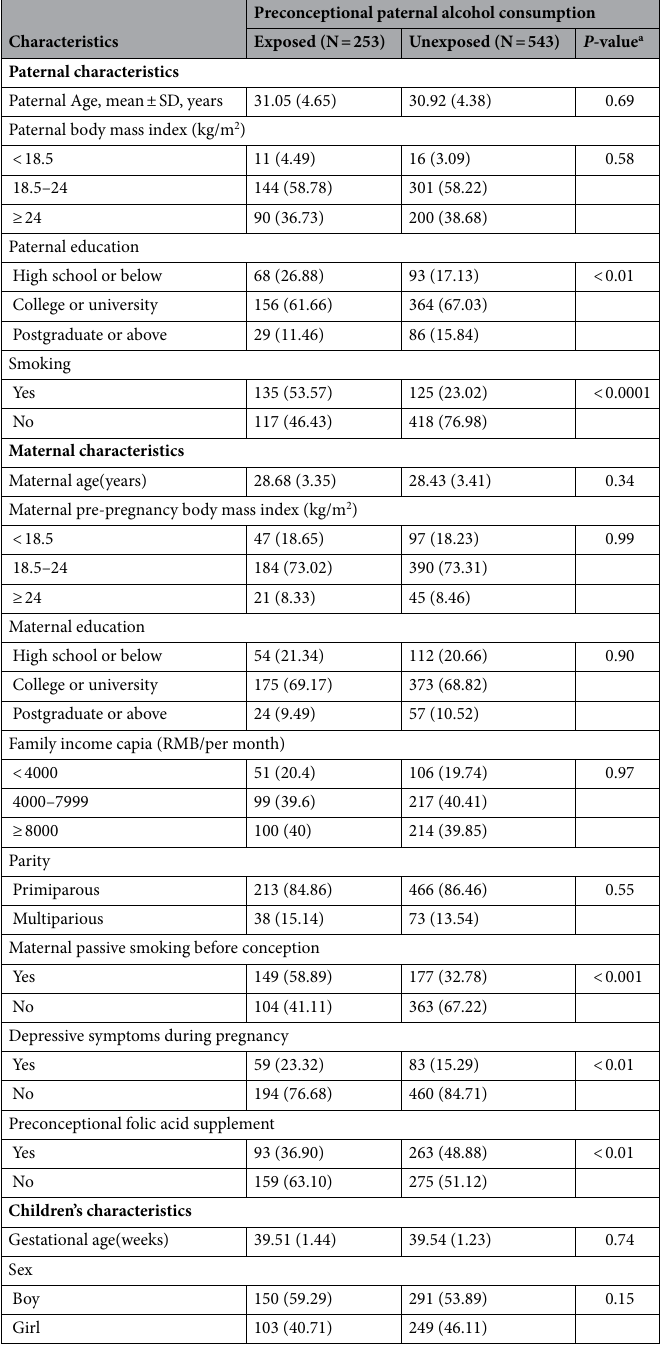
Table 1. Characteristics of children with and without preconceptional paternal alcohol consumption. Missing data: Exposed: paternal age (N = 2), paternal body mass index (N = 8), paternal smoking (N = 1), maternal